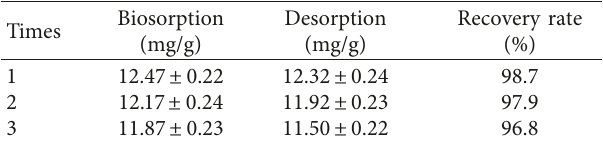
Table 2: The capacity of biosorption and desorption for Cu(II) on fermented corn stalk for three cycles.